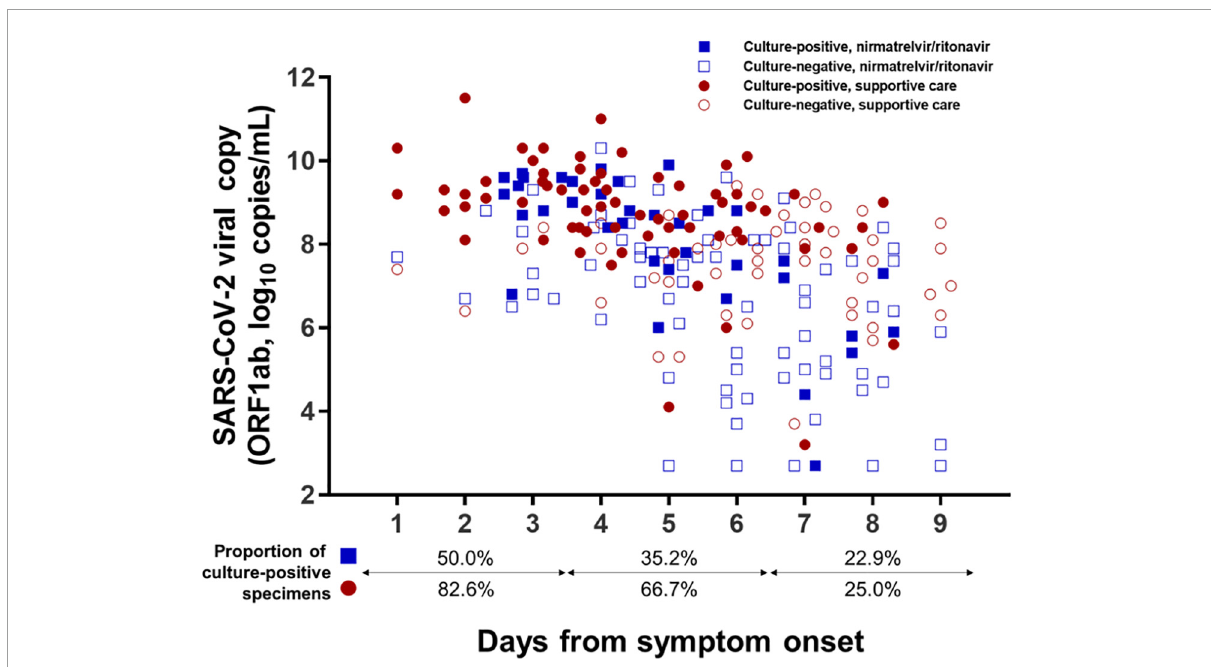
FIGURE4 Distribution of specimens with viable virus according to days from symptom onset. Culture results from a total of 222 sputum specimens obtained from 80 mildly ill COVID-19 patients are presented according to the number of days from symptom onset. Specimens exhibiting positive viral culture by the second cell passage were defined as containing viable SARS-CoV-2.